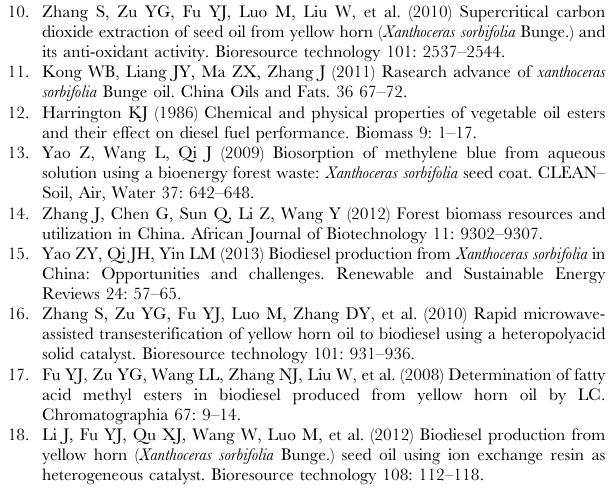
Table S1 Pathway annotation of unignenes from yellow horn.